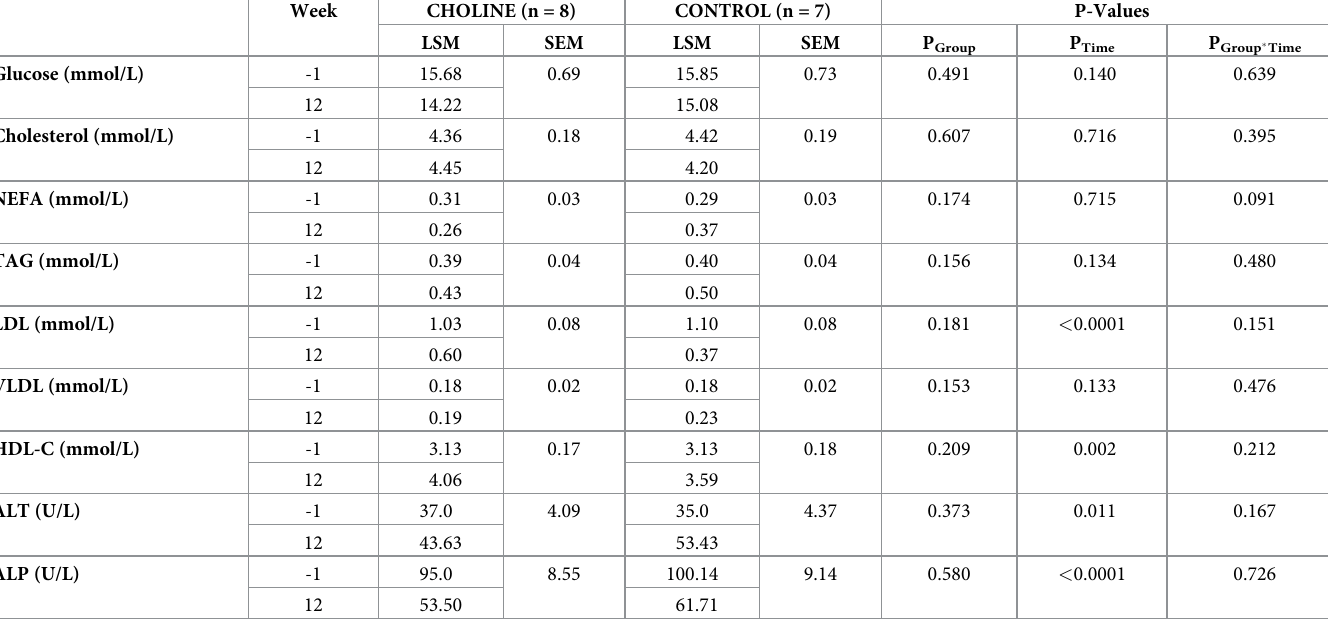
Table 4. Fasted serum concentrations of glucose, cholesterol, NEFA, TAG, LDL, VLDL, HDL-C, ALT, and ALP of post-gonadectomy kittens supplemented with additional choline at 300 mg/kg BW 0.75 (CHOLINE, n = 8) compared to a group fed only the base diet (CONTROL, n = 7) over 12